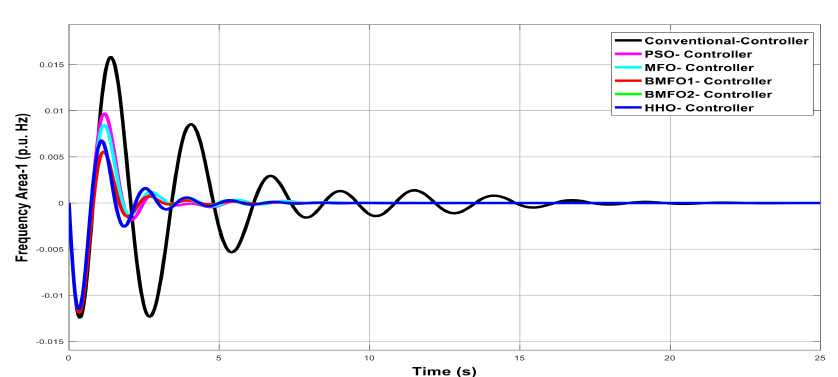
Figure 3. Dynamic response of Area1 frequency with various controllers under unilateral contract.